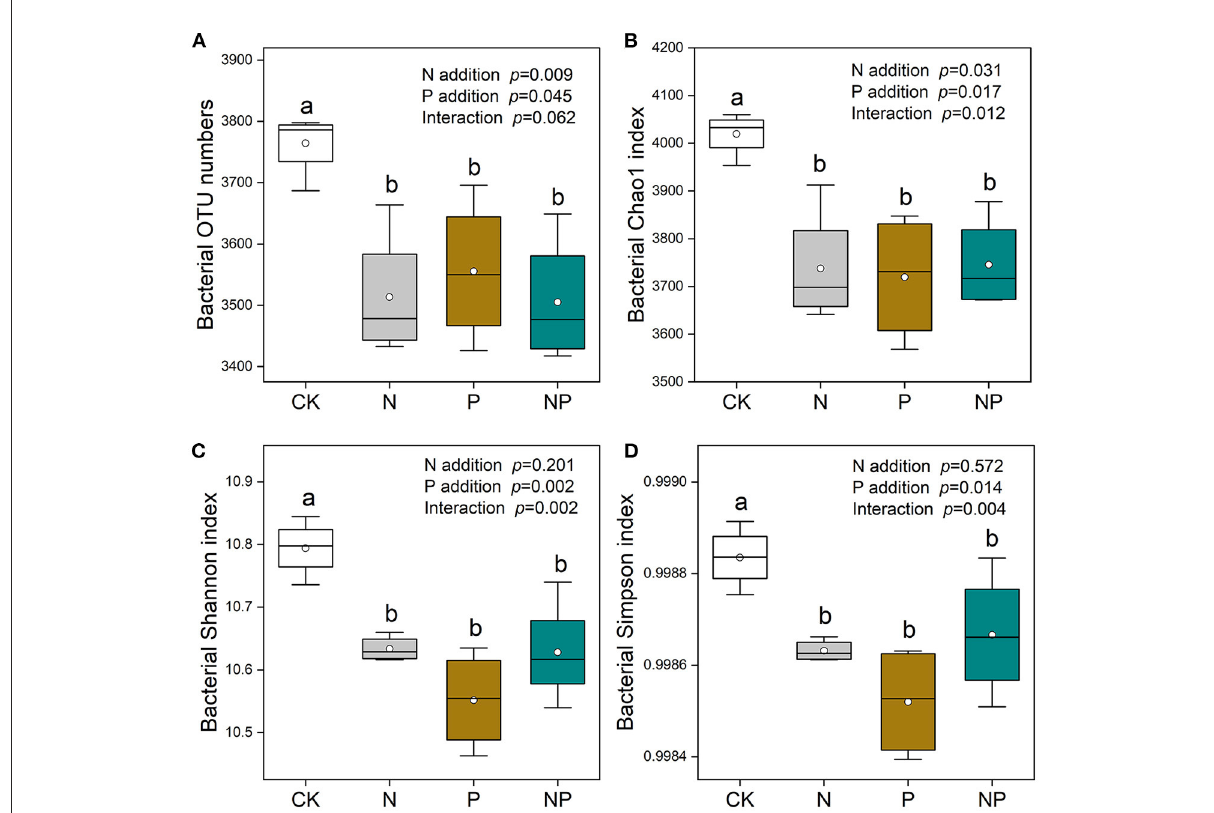
FIGURE3 The variation of soil bacterial richness [OUT numbers (A) and Chao1 indices (B) ] and diversity [Shannon (C) and Simpson (D) indices] under different nutrient additions. Values are means with SE ( n = 4). Different lowercase letters represent significant difference among treatments determined by LSD-test ( P = 0.05). CK, the control; N, nitrogen addition; P, phosphorous addition; NP, the combined addition of nitrogen and